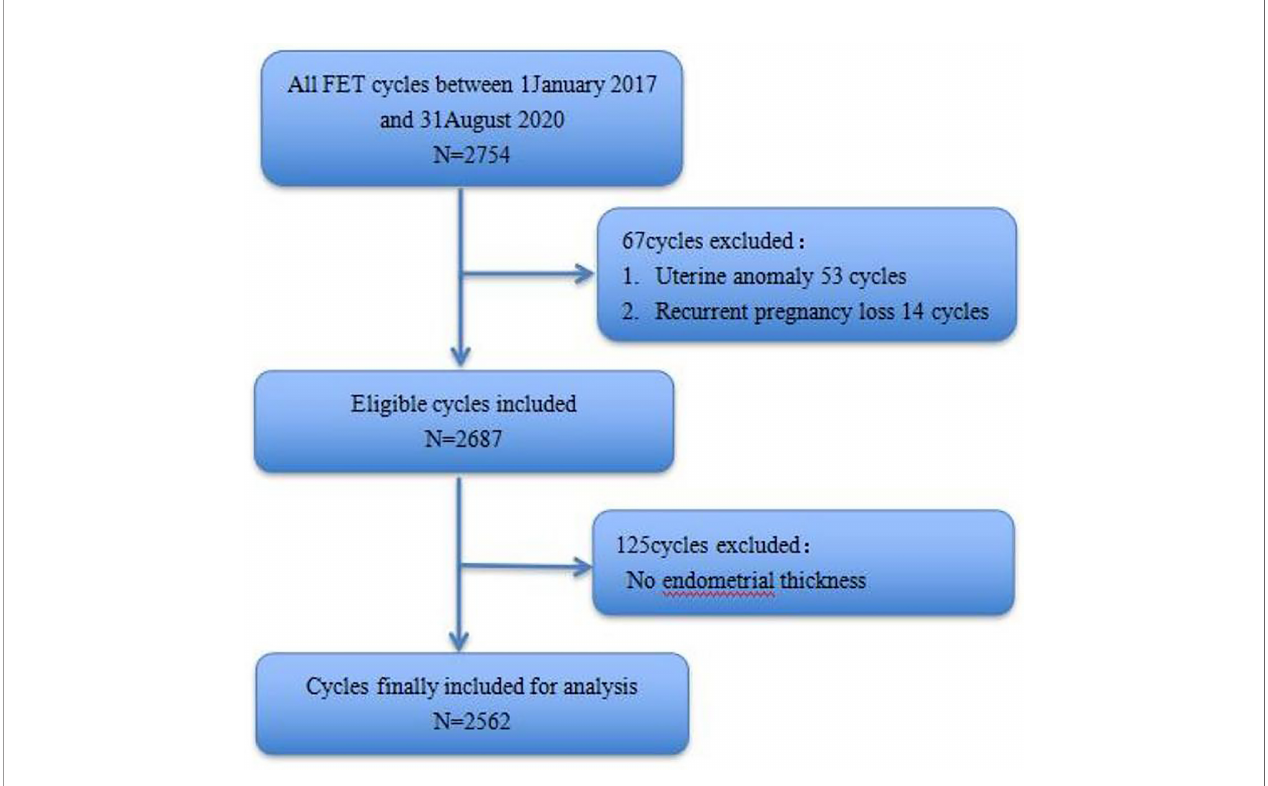
FIGURE 1 | Flow chart of the patients enrolled and the study